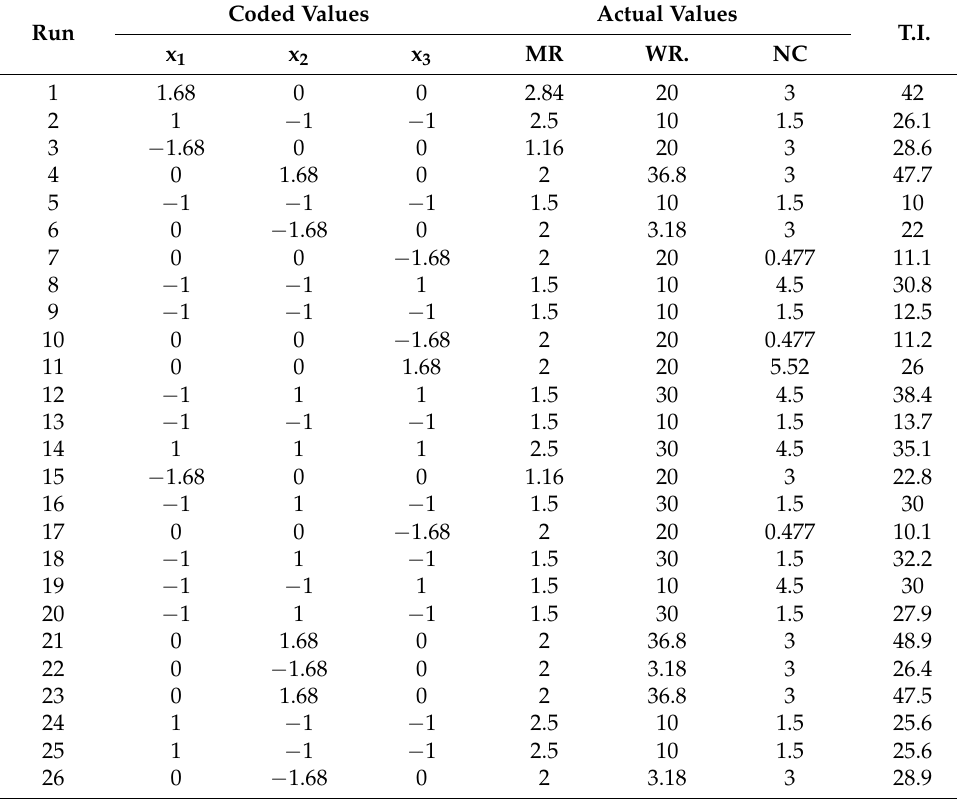
Table 2. Experimental design and response (tensile index,